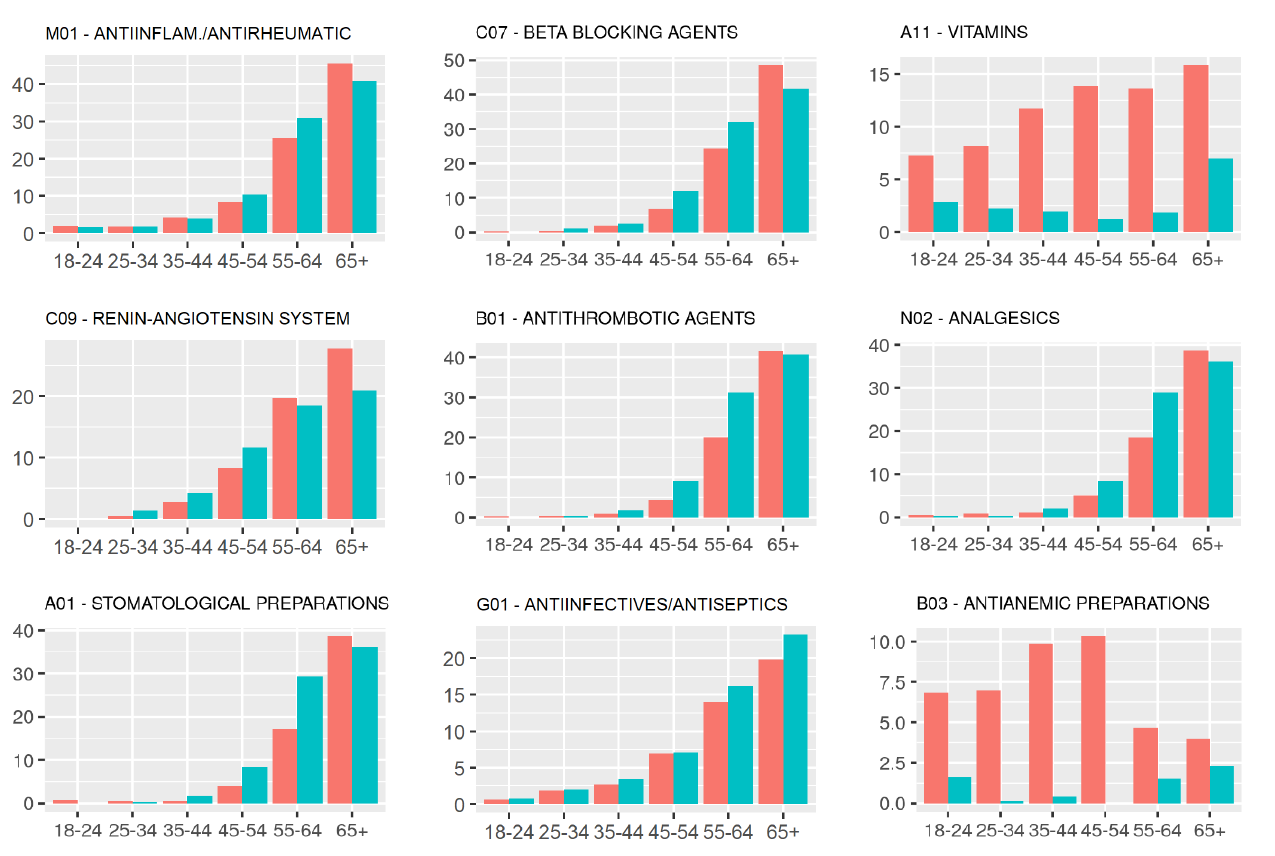
Figure 3. Frequencies (by age and sex group) of the twelve most frequently reported drug classes (ATC code level 2) by age and sex; percentages of males (cyan) and females (red) who reported at least one drug of the indicated classes in their respective age group, computed based on the responses of 6000 participants of QBB.